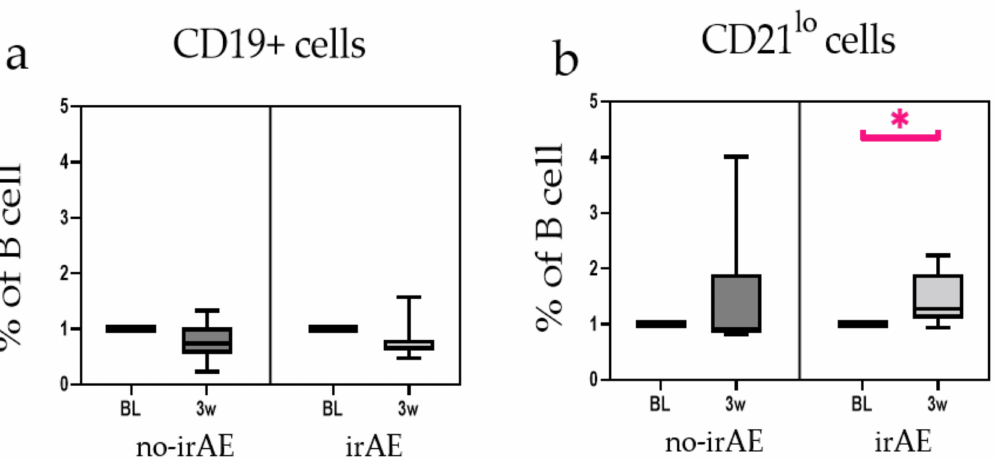
Figure 2. Immune-related adverse event (IrAE) group included eight patients who developed irAEs after 3 weeks. ( a ) Changes in proportions of circulating B cells are represented as the percentage of total peripheral blood mononuclear cells (PBMCs). ( b ) Changes in proportions of CD21 lo B cells. All data represent the mean ± standard error of mean (SEM). * p < 0.05 by two-tailed Wilcoxon signed-rank test.